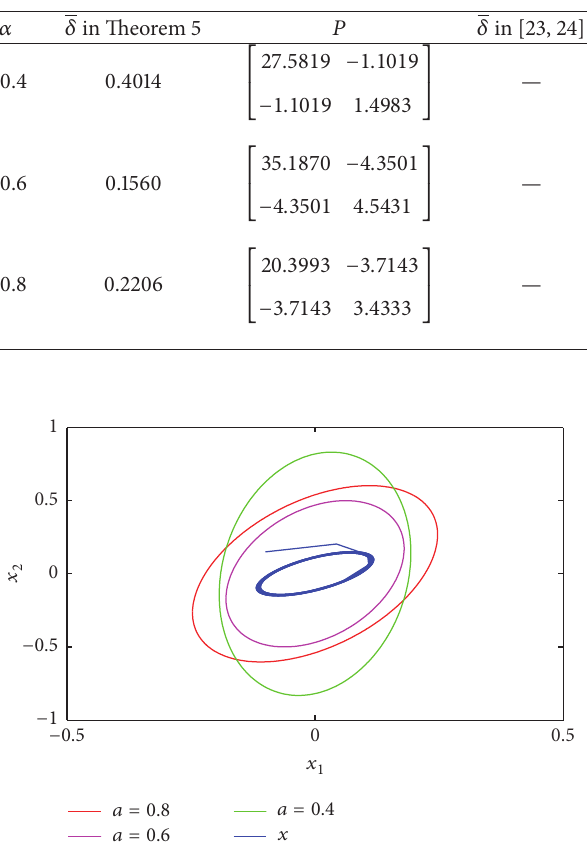
Figure 1: The reachable sets and ellipsoidal